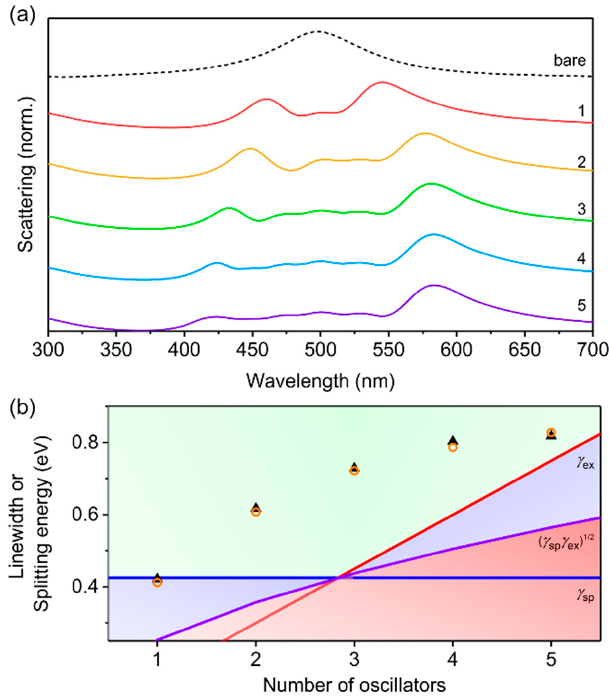
Figure 6. Variation of number of oscillators, m , for core-shell structures with shell relative permittivity described by the Franck-Condon progression (Equations (5) and (6)) and with h = 40 nm, f = 0.10; ħγ = 0.15 eV; ∆ E = 0.15 eV; ε ∞ = 3.0; and S = 1. The most intense oscillator (i.e., the 0-1 transition for m ≥ 2) was resonant with the uncoupled LSPR of the AgNP (i.e., 500 nm), with additional vibrational modes either blue- or red-shifted from the uncoupled LSPR. ( a ) Normalized scattering spectra calculated using FDTD simulations. ( b ) Splitting energy for hybrid plasmon–exciton modes calculated using FDTD simulations (black solid triangles) and Mie theory (orange open circles). The background shading represents the coupling regimes (green—strong coupling; blue—intermediate coupling; red—weak coupling) as defined by the linewidths of the surface plasmon ( γ sp —blue line), the exciton ( γ ex —red √ γ γ line), and the relationship: sp ex (purple line), given in Equations (7)–(9). The splitting energy was obtained from the scattering spectra as the di ff erence in energy between the highest and lowest energy hybrid